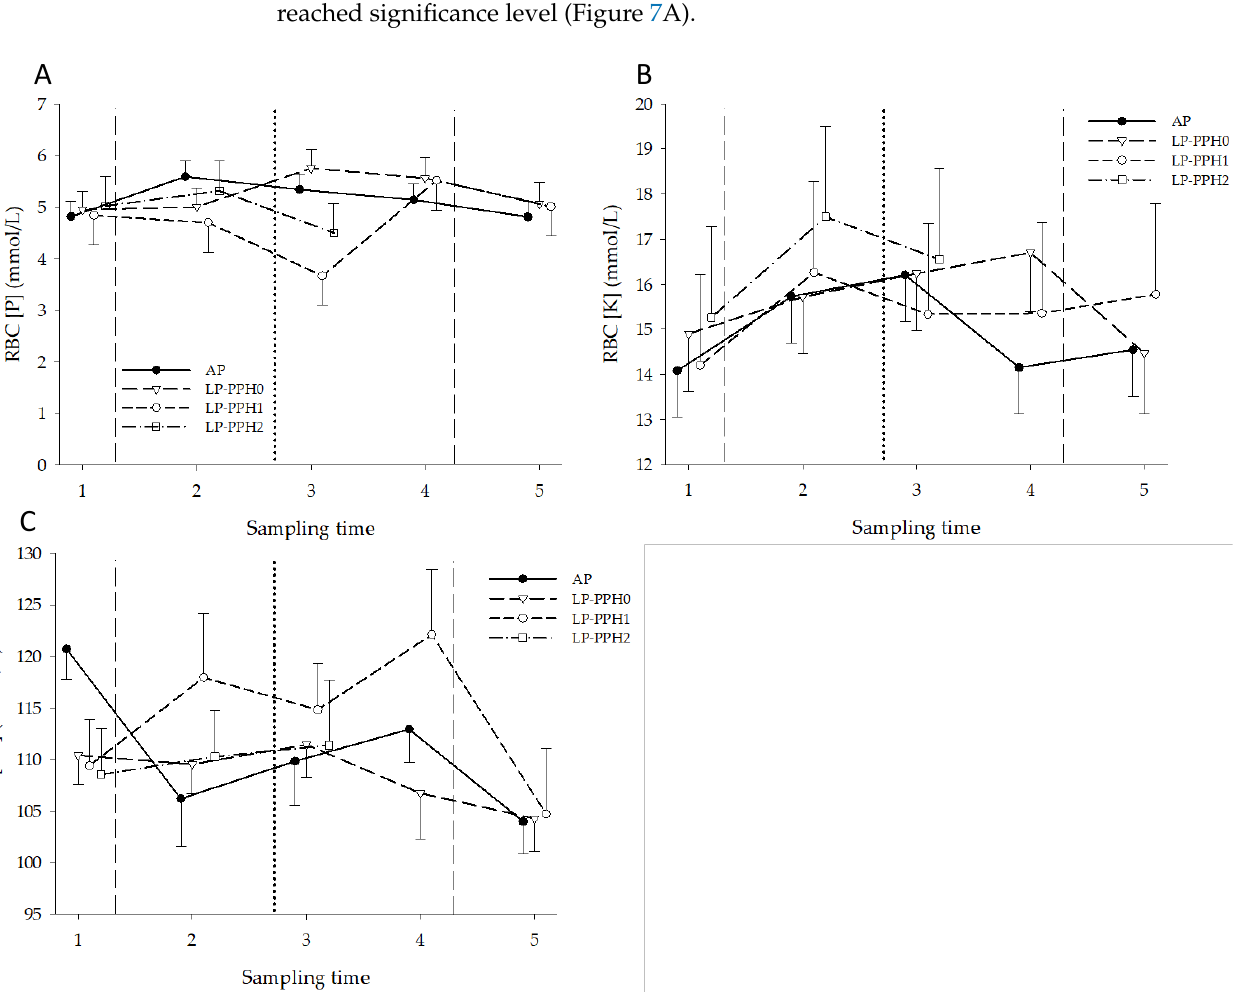
Figure 7. RBC intracellular phosphate ( A ), potassium ( B ), and sodium ( C ) concentrations in the periparturient period of dairy cattle receiving a diet with adequate P content (AP) or a P deficient diet (LP) in the periparturient period. LP-PPH2: cows that developed clinical PPH (i.e., hemoglobinuria; n = 2), LP-PPH1: cows with subclinical PPH (n = 2); LP-PPH0: cows without evidence for PPH (n = 5). The vertical dashed lines mark the beginning and end of the phosphate depletion and repletion phase of the study. The vertical dotted line indicates